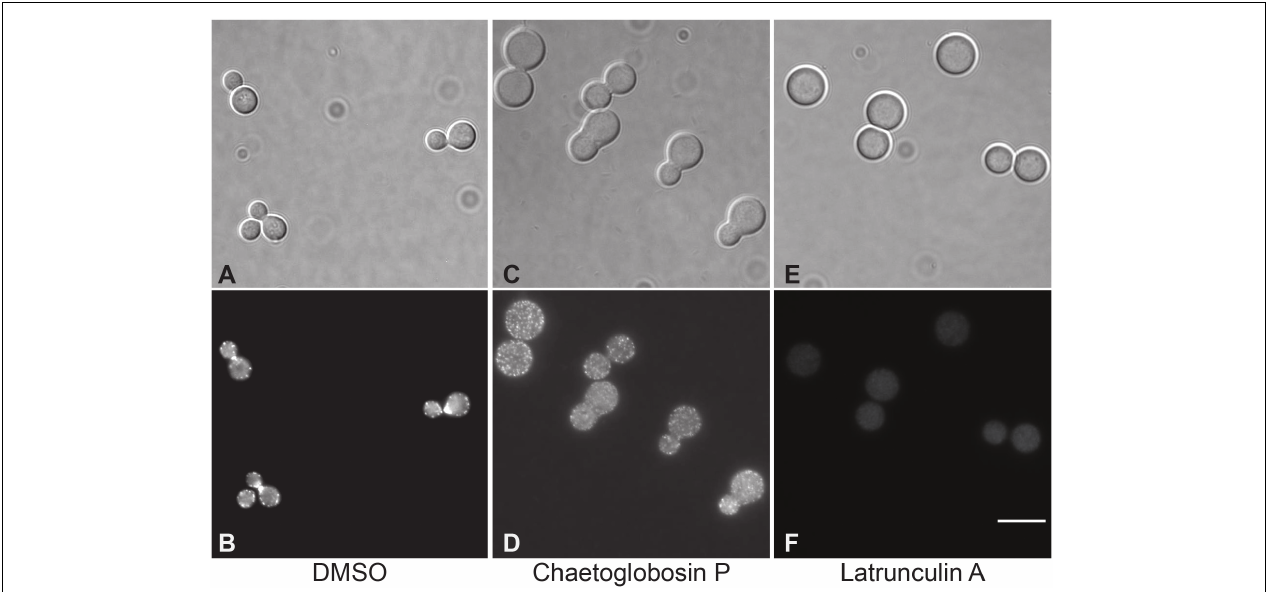
FIGURE 2 | Visualization of actin polymerization and effects of inhibitors in cells of C. neoformans . Cells were incubated overnight in YPD medium at 30 ◦ C, diluted to OD 0.2 in YPD, incubated 2 h at 30 ◦ C, then incubated for 4 h at 37 ◦ C with the indicated drug or 1% DMSO. After treatment, cells were formaldehyde fixed, permeabilized, then incubated with TRITC-conjugated phalloidin which binds to F-actin structures. (A,B) DMSO, negative control. (C,D) Treatment with chaetoglobosin P. (E,F) . Latrunculin A, positive control.